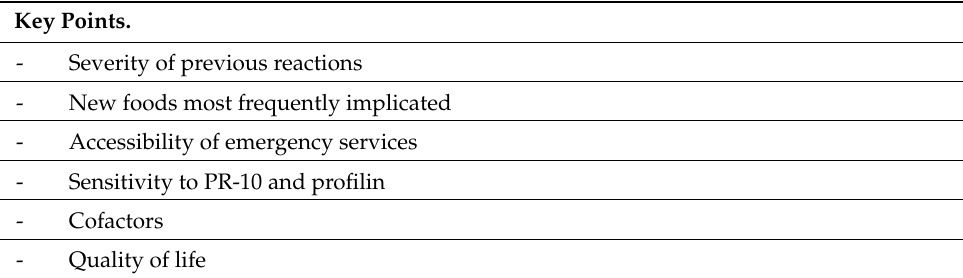
Table 5. Risk stratification of nsLTP-allergic